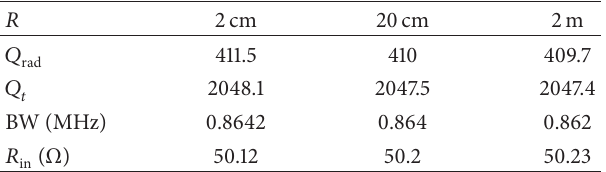
, 𝑄 𝑡 , BW, and 𝑅 for different radius of curvatures. Table 2: 𝑄 rad in 𝑅 2cm 20cm 2 m 𝑄